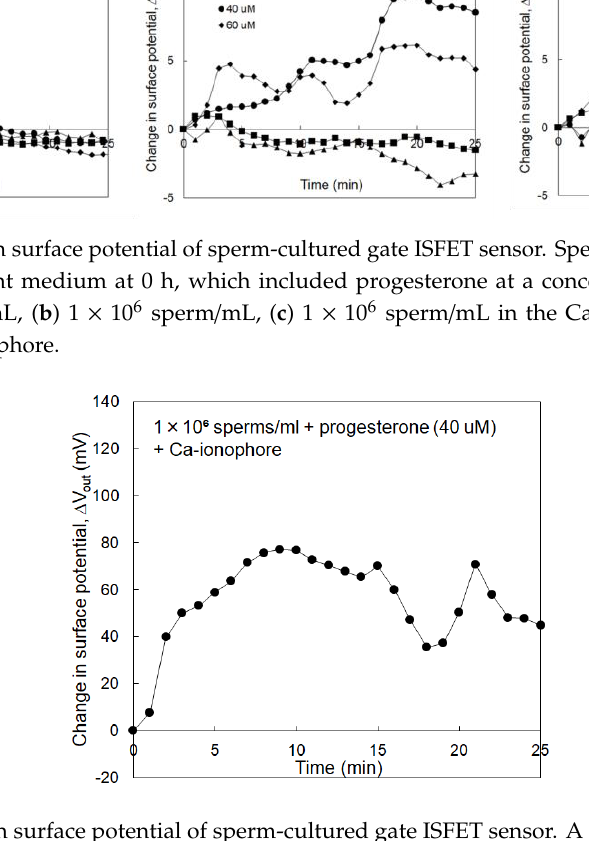
Figure 4. Change in surface potential of sperm-cultured gate ISFET sensor. A total of 1 × 10 6 /mL of spermatozoa were added to the measurement medium at 0 h, which included 40 µ M of progesterone and 10 μM of Ca ionophore.